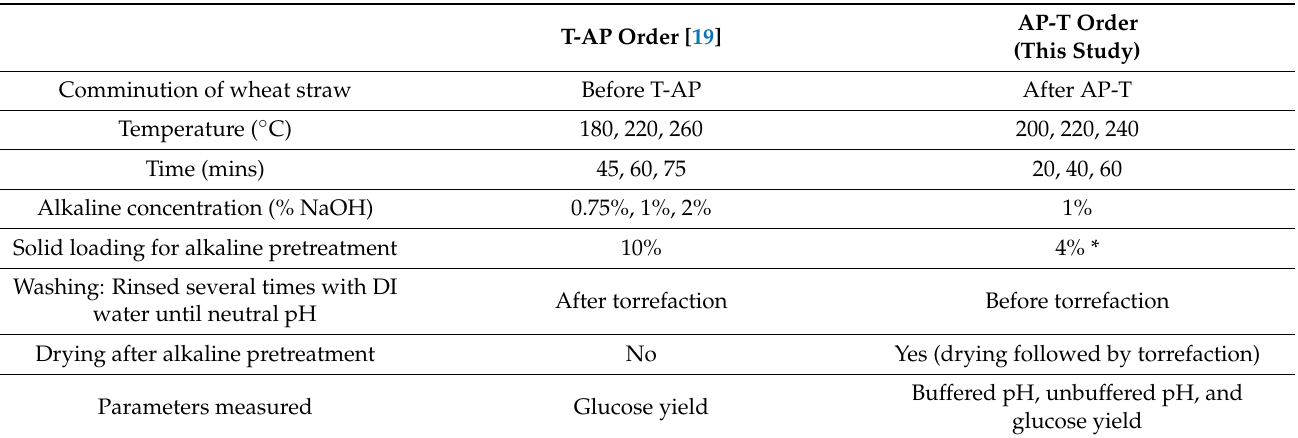
Table 1. Comparison of Experimental